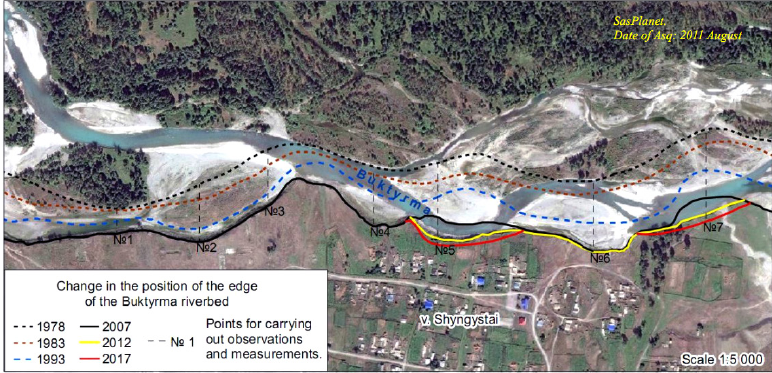
Figure 3. Change in the position of the edge of the Buktyrma riverbed in the area of the Shyngystai